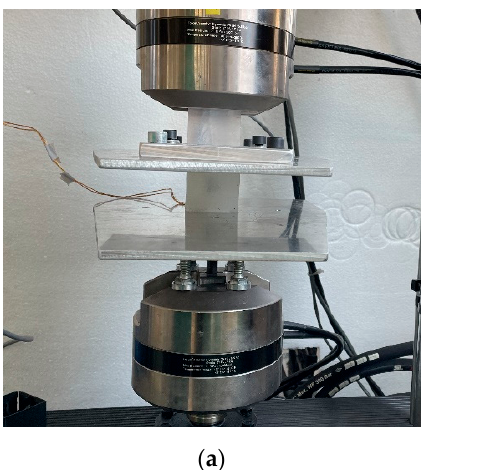
( d ) Figure 5. Preparation and testing of the uniaxial pressure sensor: ( a ) Pressure sensor positioned over the first half of the rubber specimen. ( b ) Cylindrical specimen ready for the test. ( c ) Compression test. ( d ) Tension test. 2.6. Calibration of the MAPS Probe To calibrate the MAPS probe, we used a MiniBionix II (MTS) testing machine. This machine is actuated by a servo hydraulic cylinder (stroke: 100 mm) and is equipped with